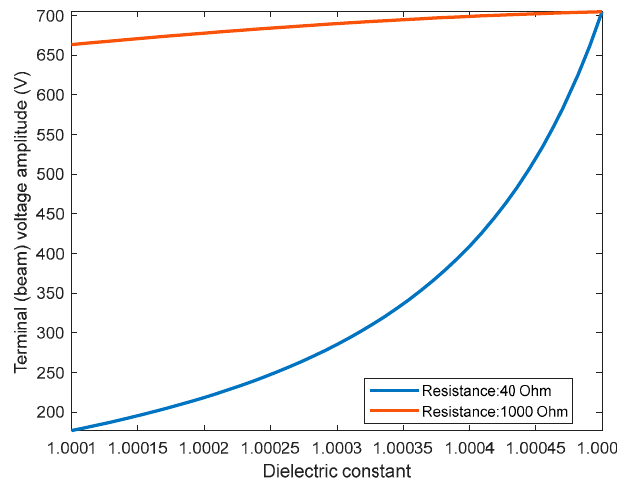
Figure 9. The effect of the resistance on the amplitude of the terminal voltage as a function of the dielectric constant.